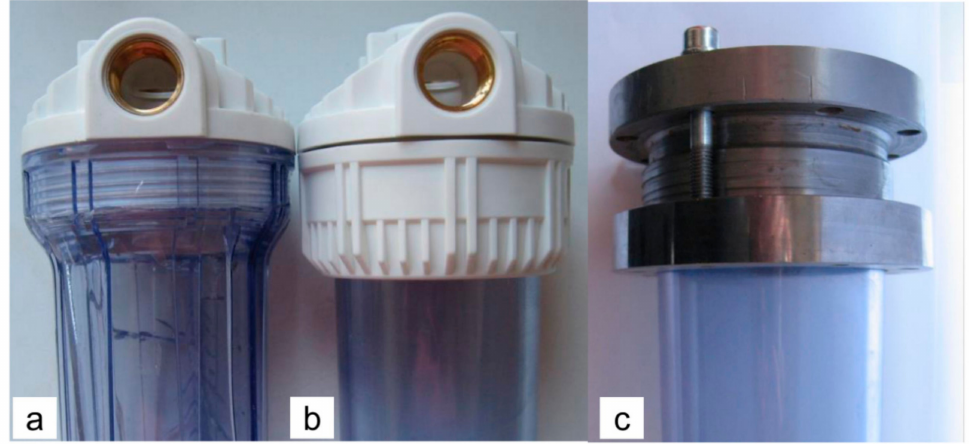
Figure 2. Di ff erent ways of fitting the housings to the head for the di ff erent samples ( a ) series A ( b ) series B ( c ) series C and